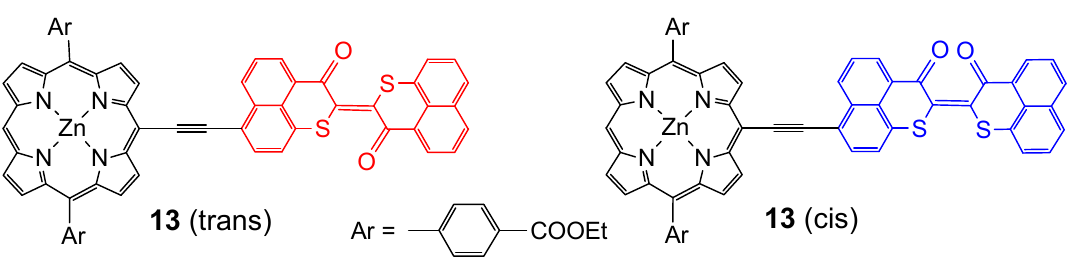
Scheme 14. Photoisomerization of 13